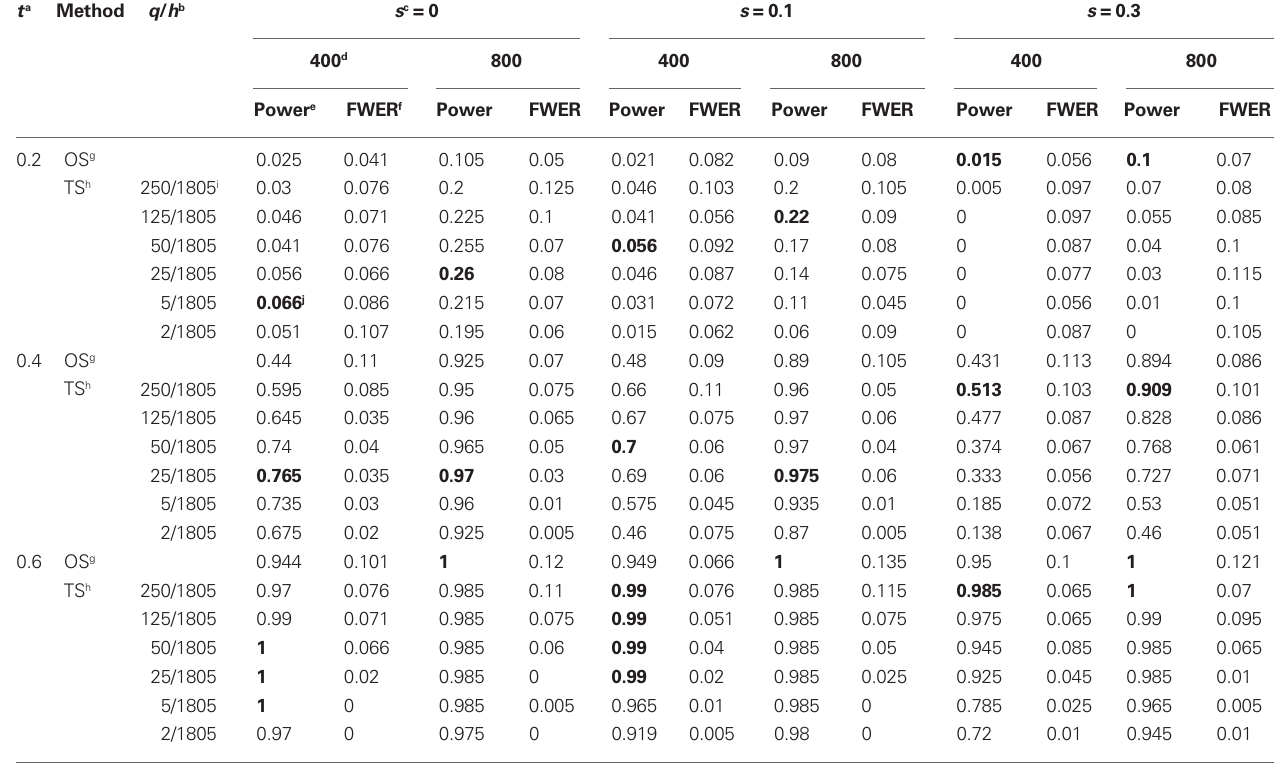
Table 3 | empirical power and FWer of the two-stage procedure at a significance level of 0.1 (200 replicates). t a method q / h